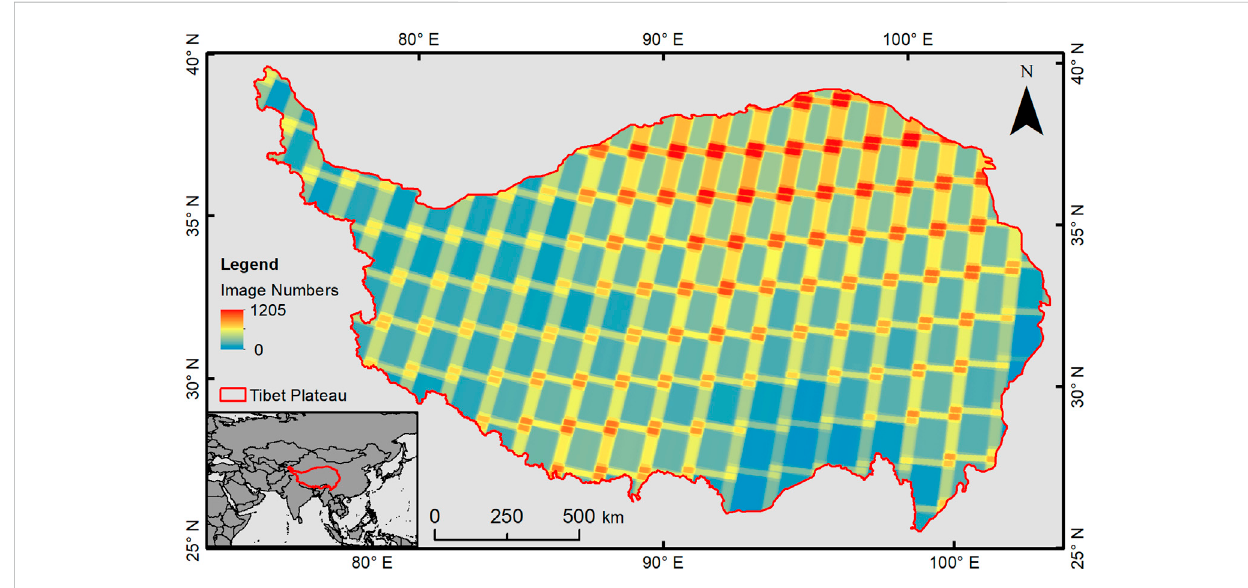
FIGURE 1 Landsat image numbers and QTP location (1990 – 2020 Landsat TM, ETM+ and OLI image).